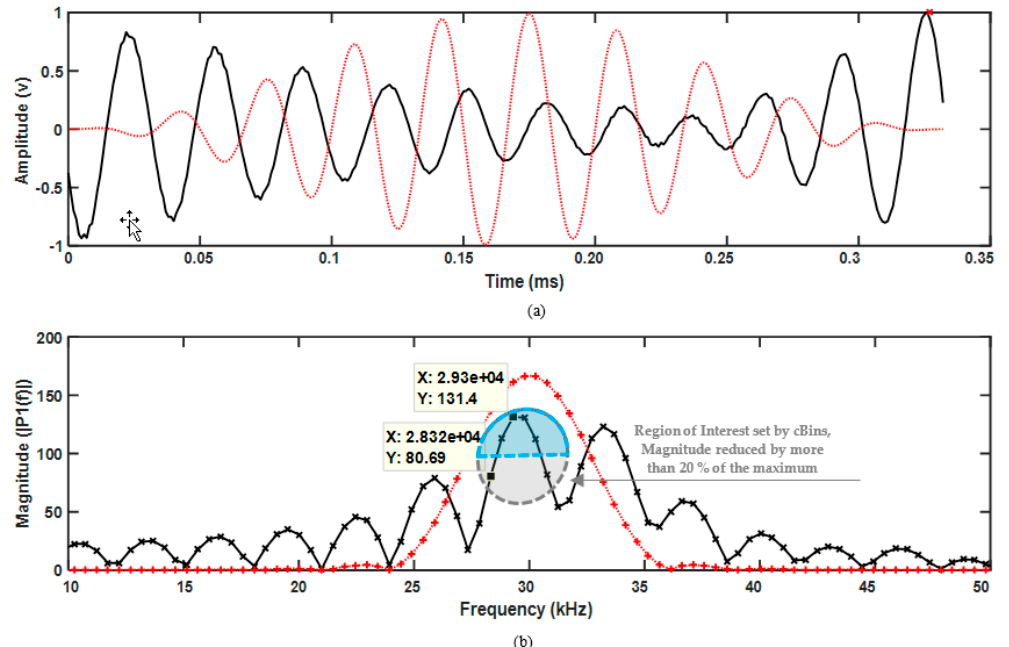
Figure 8. Example of an outlier case detected using Condition Two (C2), where ( a ) shows the time domain of the iteration window and ( b ) is its respective power spectrum. The red lines (dotted, +) show the references achieved from excitation sequence and the black lines (solid, x) show the results from each iteration.